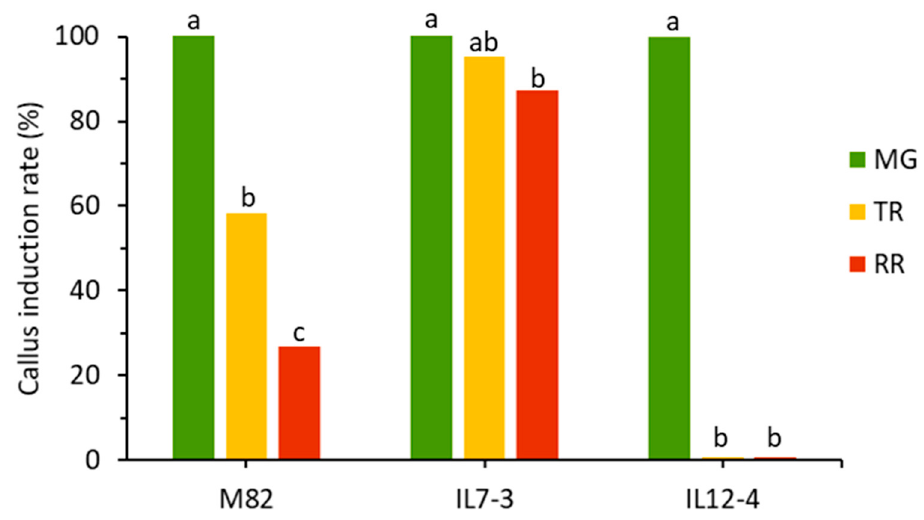
Figure 1. Callus induction frequency of the tomato genotypes. Explants of fruits at three maturity stage (MG: mature green; TR: turning red; RR: red ripe) were cultured on callus induction medium and the frequency of explants showing callus was determined after 15 days. For each genotype, different letters (a–c) represent statistically significant differences ( p ≤ 0.05) among fruit explants.